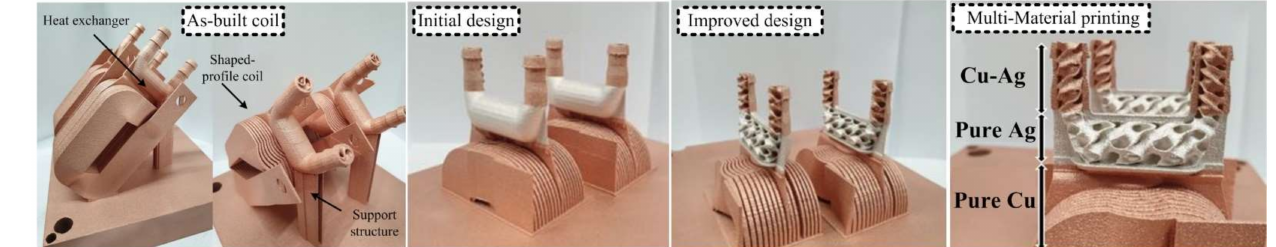
Figure 14. Multi-material AM shaped-profile coils with integrated heat exchangers for improved thermal performance [42].